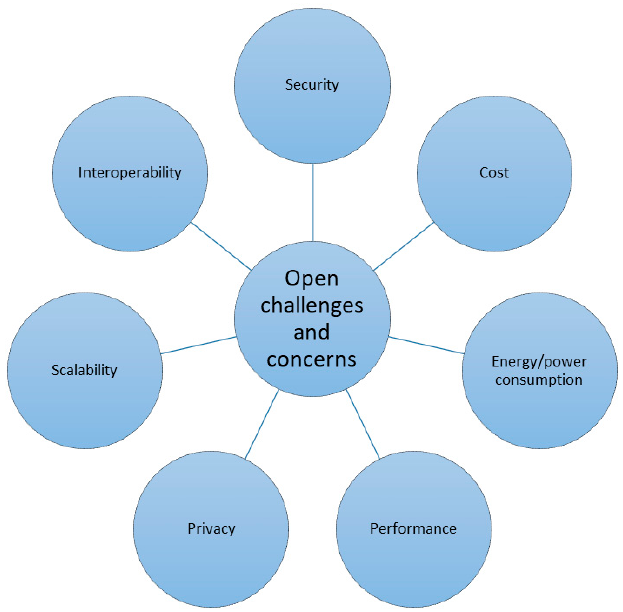
Figure 11. Open challenges and concerns are found in all